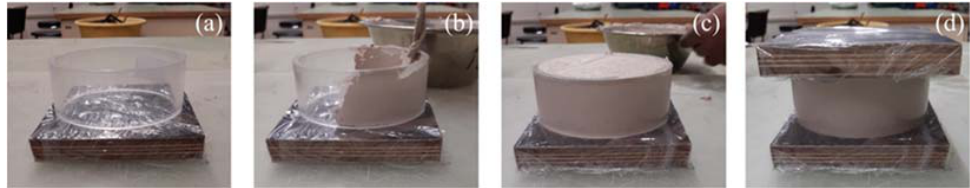
Figure 2. Sample preparation for oedometer testing of uncemented and artificially cemented soil specimens: Summary of individual working steps ( a – d ).